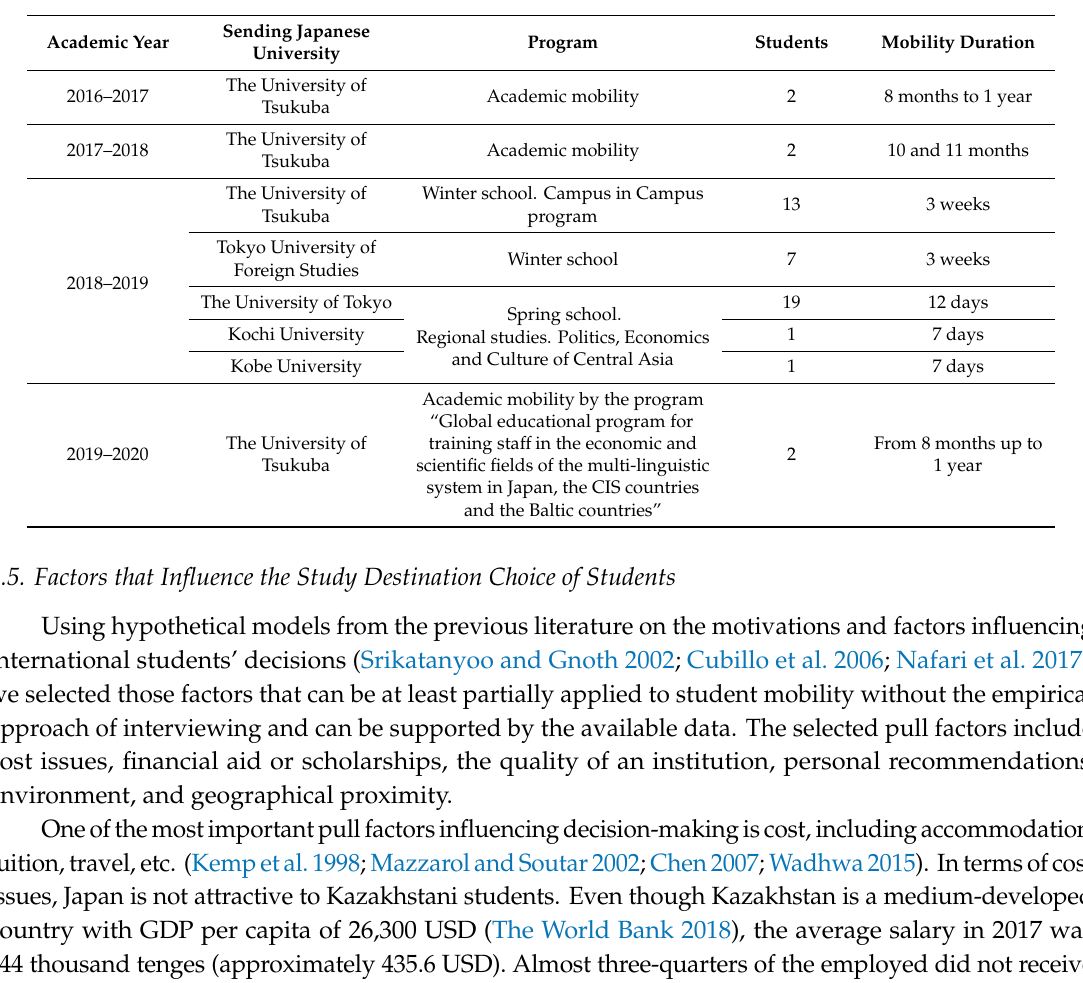
Table 5. Inbound student mobility from Japanese partner universities to Al-Farabi KazNU,